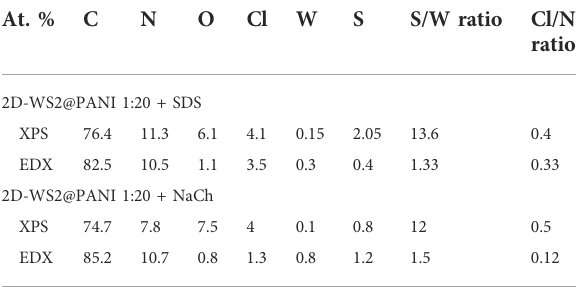
TABLE 2 Comparison between atomic % of different elements in 2D WS2@PANI nanohybrids as obtained from XPS and EDX analysis. At.